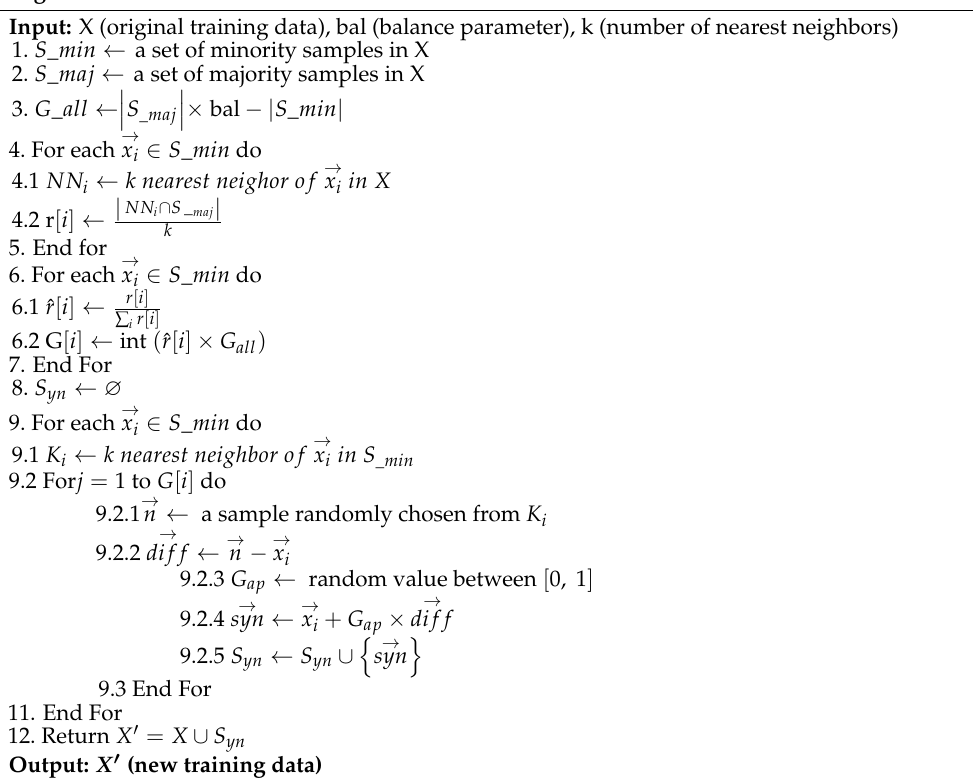
Algorithm 4: Pseudo code for ADAYSN